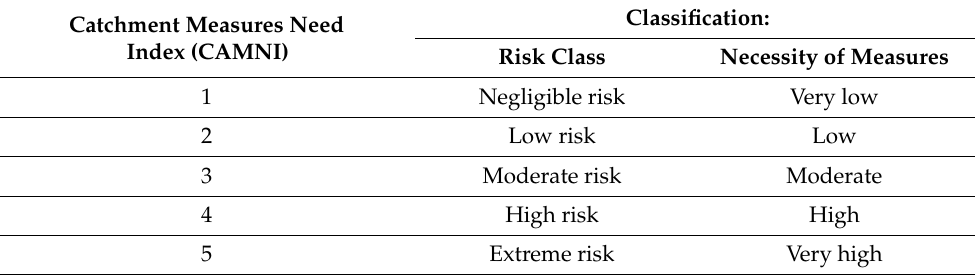
Table 2. Definition of risk assessment classes for the Catchment Measures Need